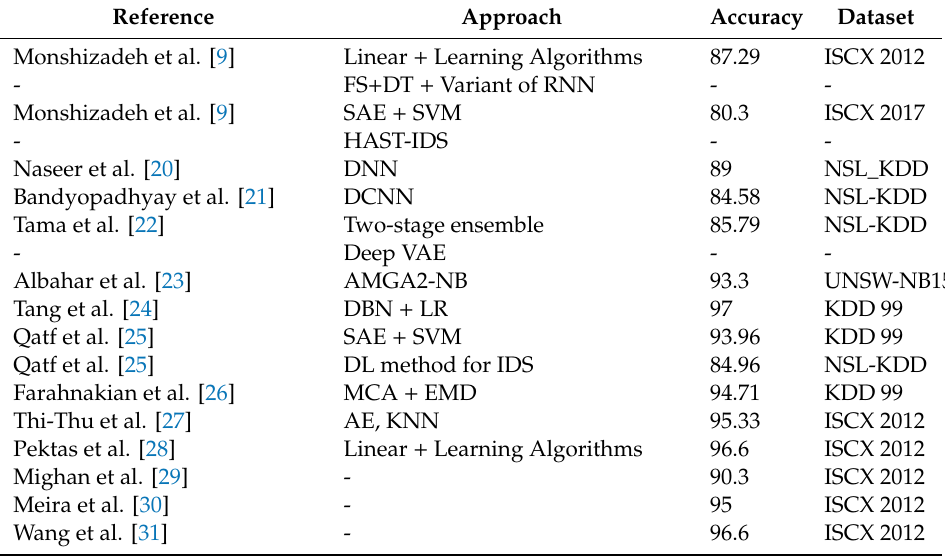
Table 2. Summary of the related works using di ff erent